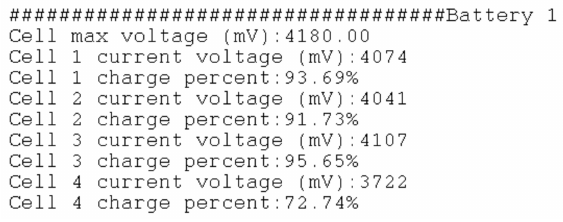
Figure 10. Battery cell voltage report by the